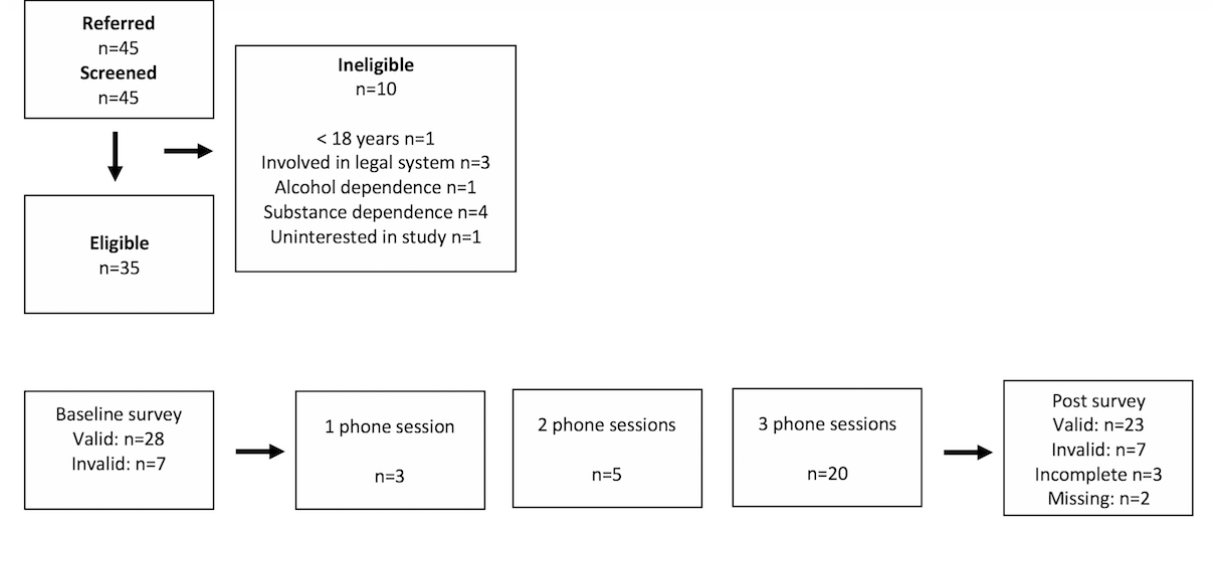
Figure 3. Participant flow through recruitment and intervention.